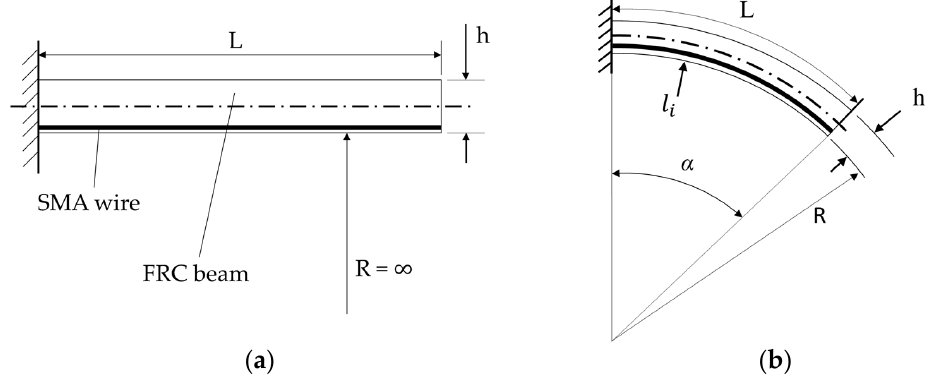
Figure 2. Geometrical description of the bending beam mechanism with a straight beam ( a ) and in bent shape ( b ).